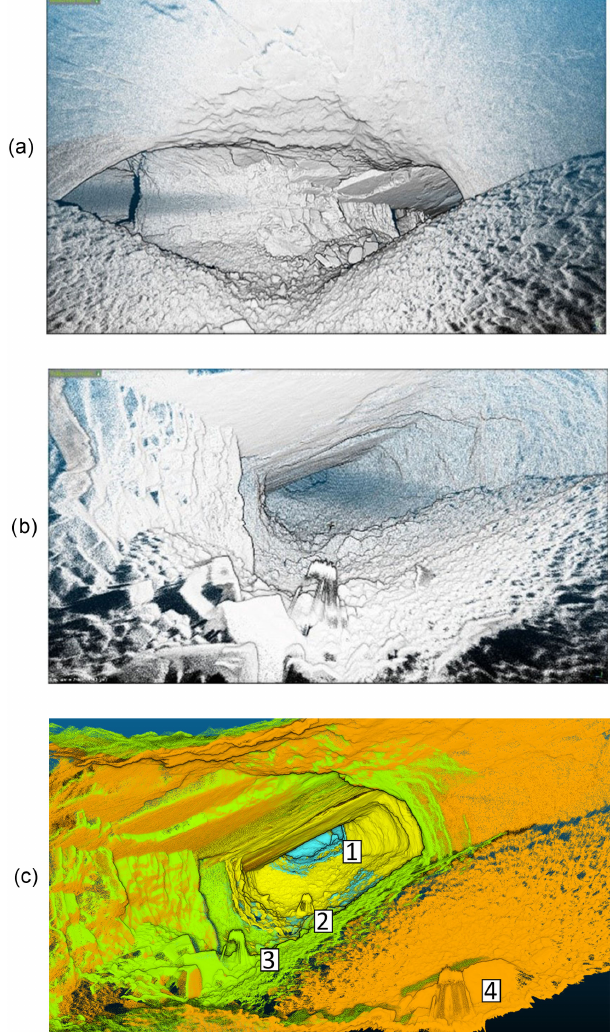
Figure 8. Scanned scenes in Baulmes mines. The height of the gallery is about 3.5m: (a) mine example 1; (b) mine example 2; (c) point cloud registration in the